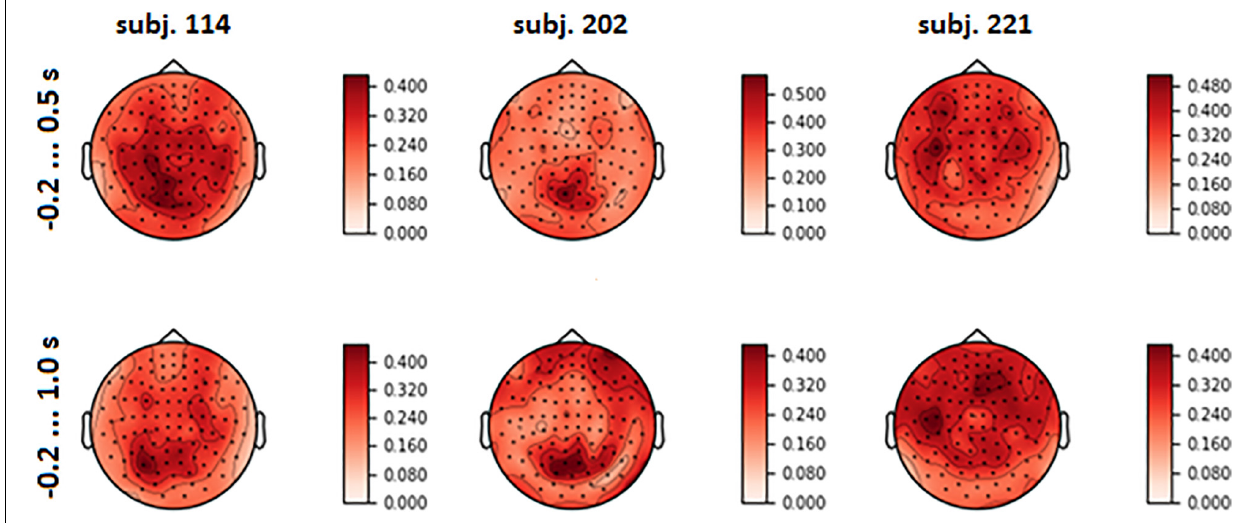
FIGURE 7 | Topographical maps of full explained variance fraction (FVE) for the same participants as in Figure 6 (For the maps for other participants, see Supplementary Figure 3 in Supplementary Data Sheet 1 ).